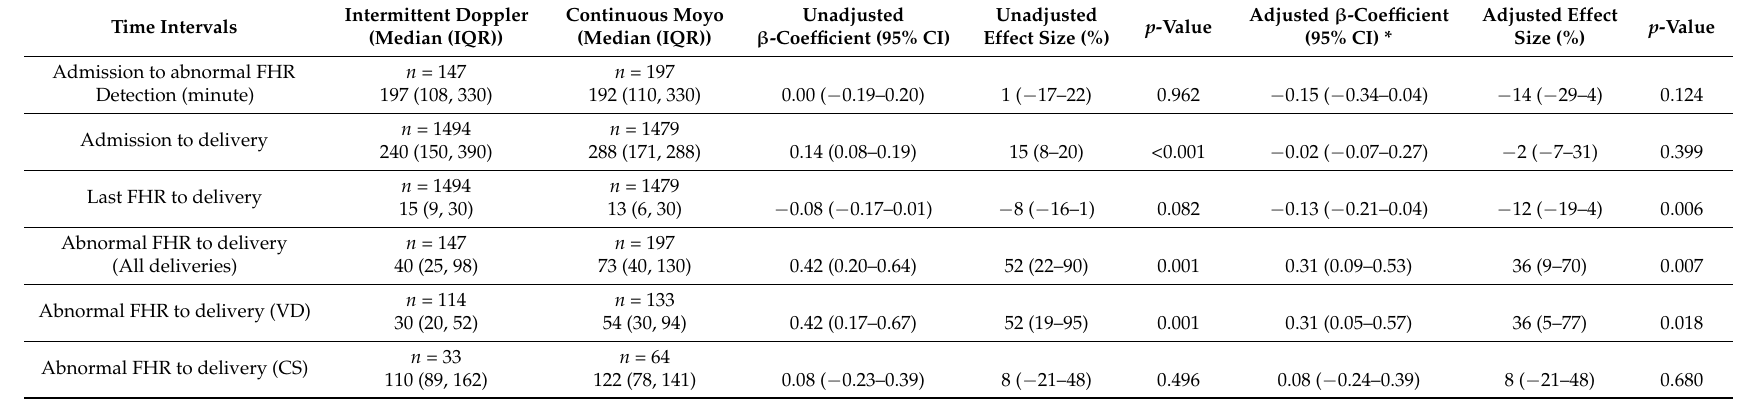
Table 3. Comparison of time intervals (in minutes) between intermittent Doppler and continuous